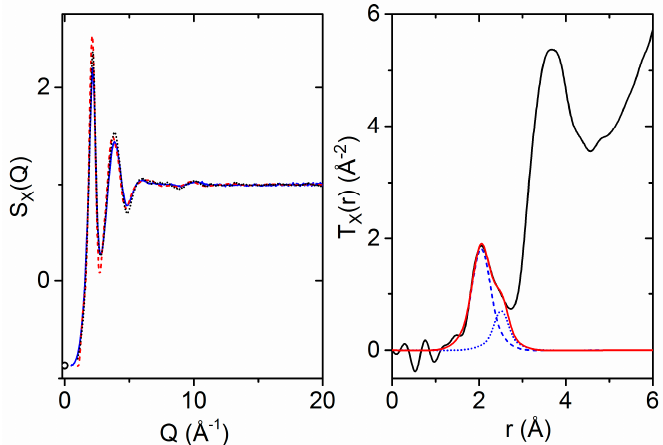
Figure 4. ( Left ) X-ray structure factors of molten HfO 2 at 2900 °C measured on 11-ID-C (solid blue line) and at 3000 °C measured on 6-ID-D (black dots) compared to the results of the ab initio MD simulation (red dashes). The circle represents the isothermal compressibility limit at Q = 0 Å − 1 [14]. ( Right ) X-ray weighted total pair distribution function (black) obtained via Fourier transform with a variable modification function applied [41,42] (Q max = 20 Å − 1 ) compared to individual Gaussian atom distributions (blue dashes/dots) convoluted with the X-ray form factors and their sum (red). A comparison of the HfO 2 melt X-ray structure factor and corresponding pair distribution function with those of amorphous hafnia is shown in Figure 5. Distinct oscillations in S(Q) for Q > 5 Å − 1 appear in the amorphous signal that are not readily apparent in the liquid state.